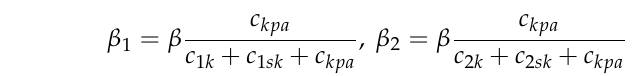
Figure 27. Wheel load recalculation scheme when the vehicle is subjected to lateral force. The tilt of the front and rear wheels is equal to: